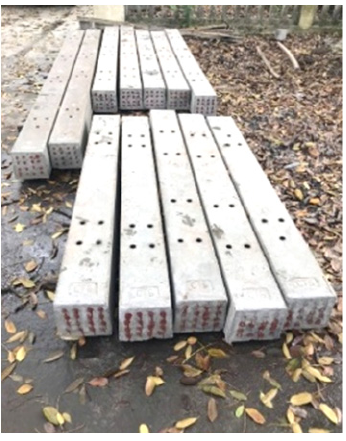
Figure 5. Produced samples of PSB.